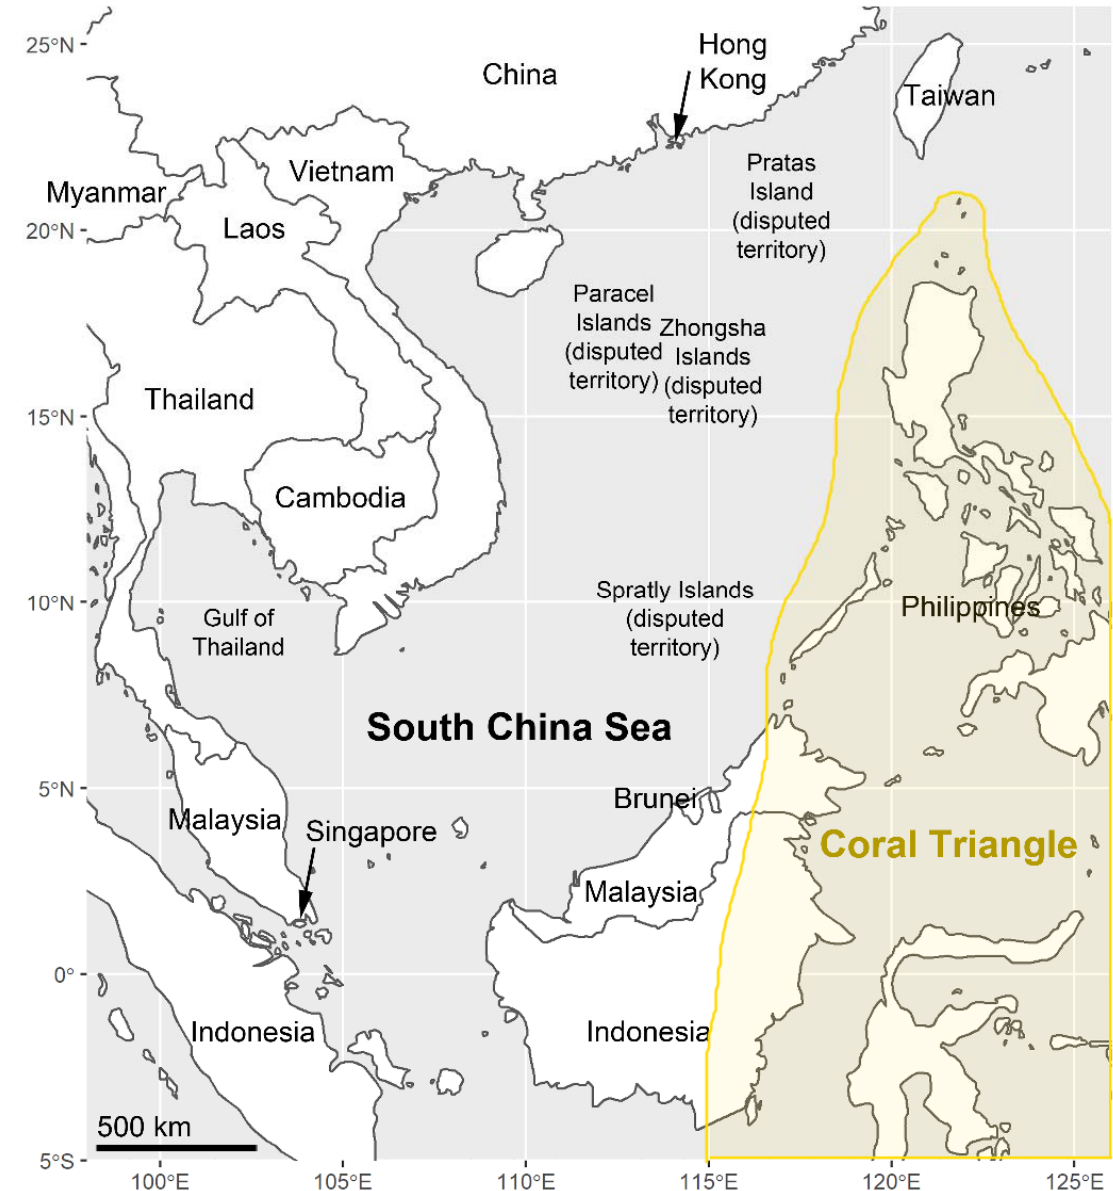
Figure 1. Map of the South China Sea, surrounded by the coasts of the stakeholder countries. Major disputed territories are marked in oceanic areas of the South China Sea. The area neighbors the Coral Triangle (highlighted in yellow).